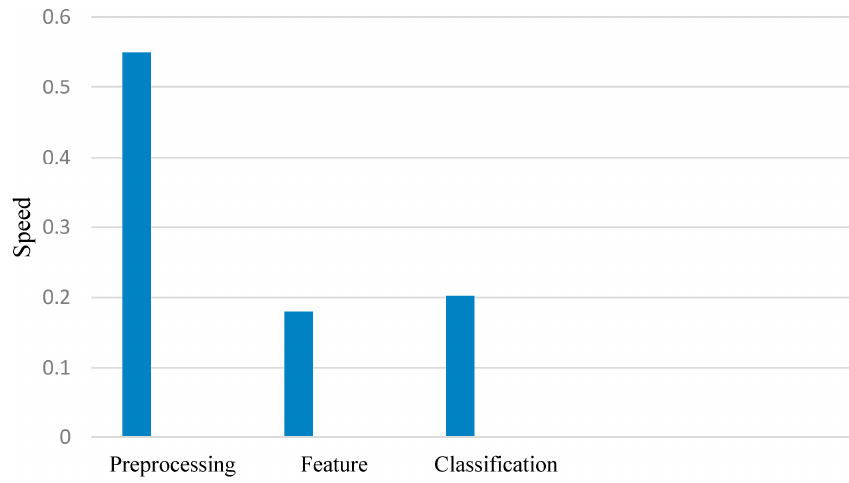
Figure 7. The execution time of each part for the proposed algorithm on FPGA.